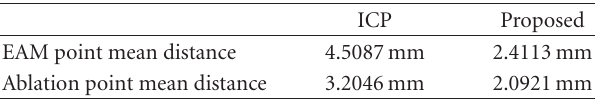
Table 1: Performance comparison of ICP and the proposed